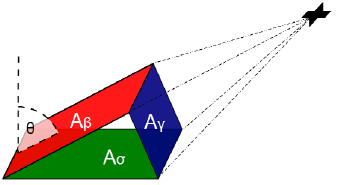
Figure 5. Three reference areas of SAR backscatter